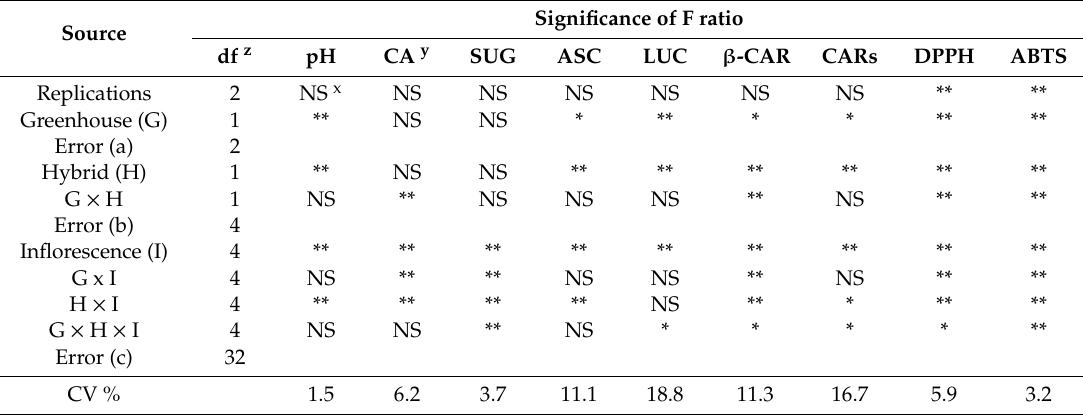
Table 4. Variance analysis of physical parameters, bioactive ingredients, and antioxidant characteristics, as influenced by the greenhouse type [DSSC (Dye-Sensitized Solar Cell) and CONV (Conventional)] and the species of tomato hybrid [MST (medium-sized) and ChT